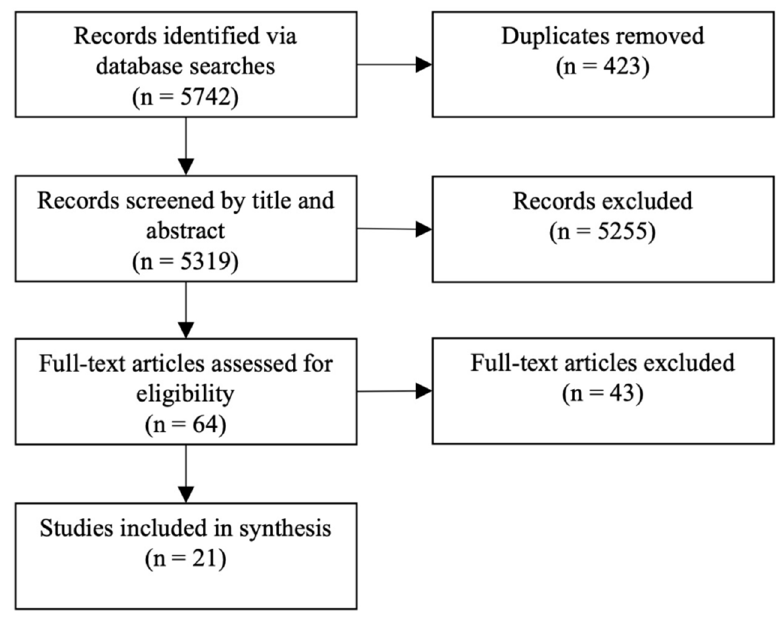
Figure 1. Scoping flow diagram.